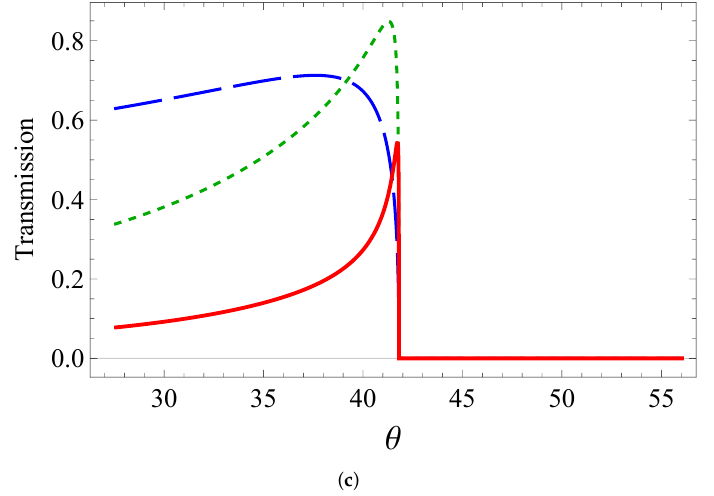
Figure 2. ( a ) Field enhancement factor, ( b ) absorption, and ( c ) transmission as a function of incidence angle θ (degrees): circles (short dashes), vertical ellipses (long dashes), horizontal ellipses (solid